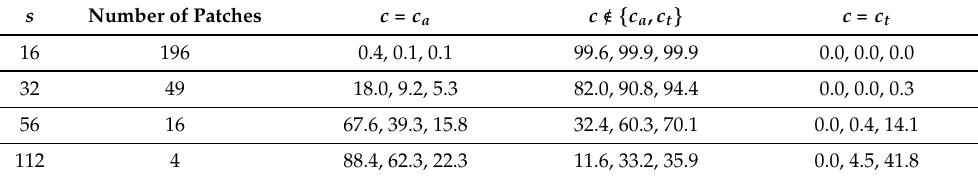
Table 4. Percentages of shuffled images sh σ (A p q , s ) (first percentage), sh σ ( D EA percentage), and sh σ ( D BIM